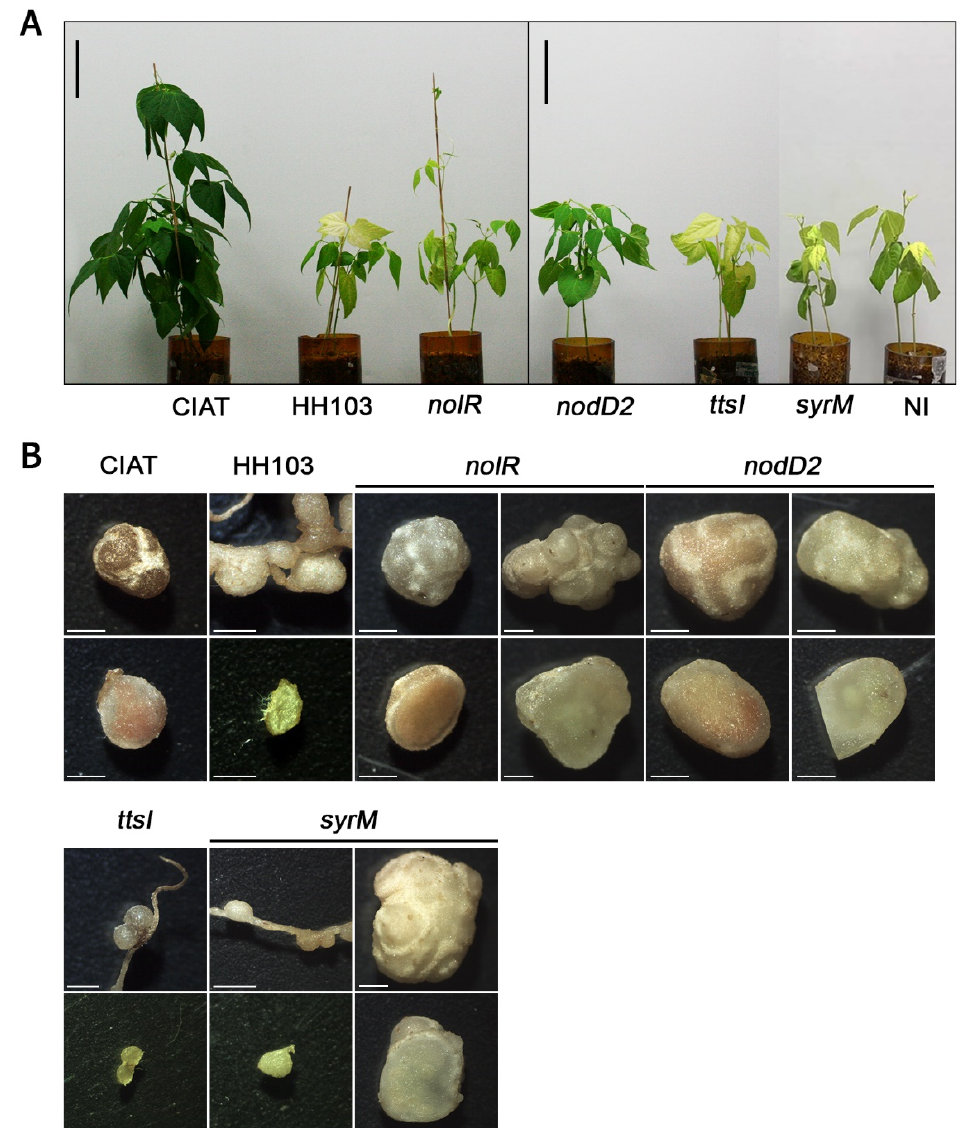
Figure 4. Symbiotic performance of R. tropici CIAT 899, S. fredii HH103 and its nodD2 , nolR , syrM , and ttsI derivatives with Phaseolus vulgaris . Appearance of aerial parts (panel ( A )), and nodule and pseudonodule morphology (panel ( B )). Bars represent 10 cm for panel ( A ) and 1 mm for panel ( B ).